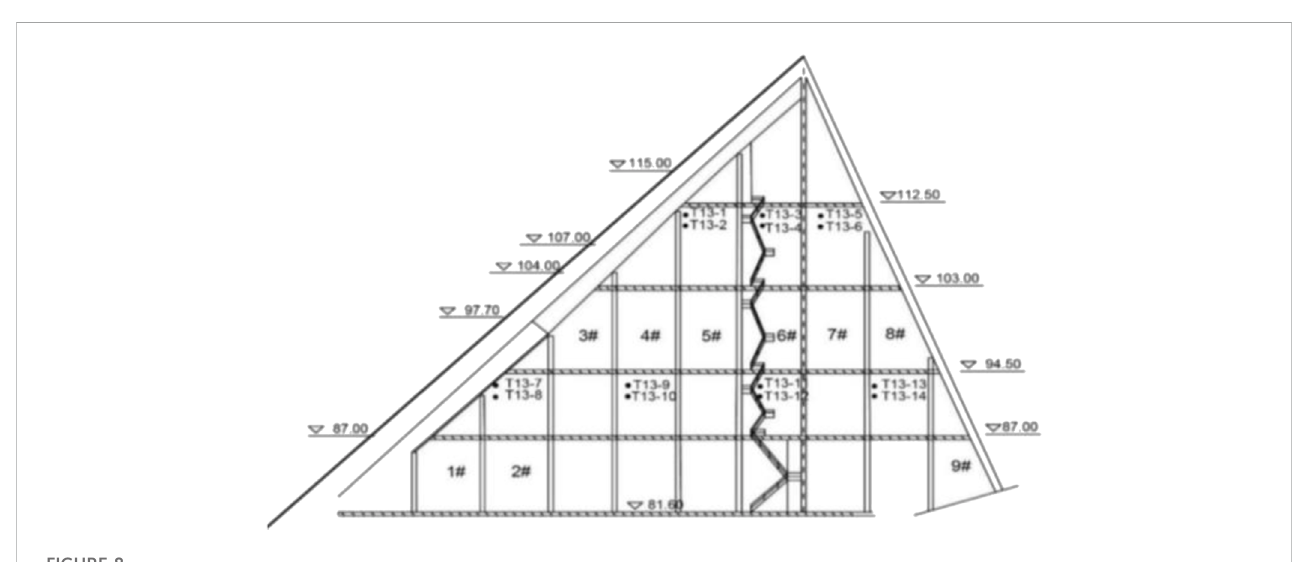
FIGURE 8 Thermometers installed in the dam section